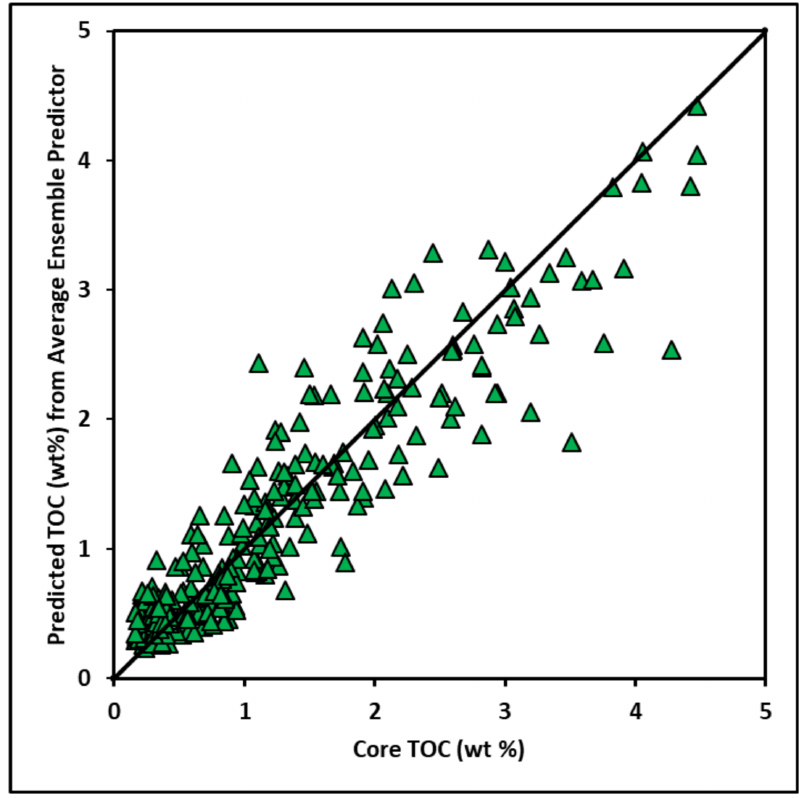
Figure 16. Cross ‐ plot of core TOC and average ensemble predictor estimated TOC of all studied wells in the Goldwyer formation. The black line implies a 1:1 ratio. Prediction is not still perfect but improved significantly with R 2 value of 0.86.